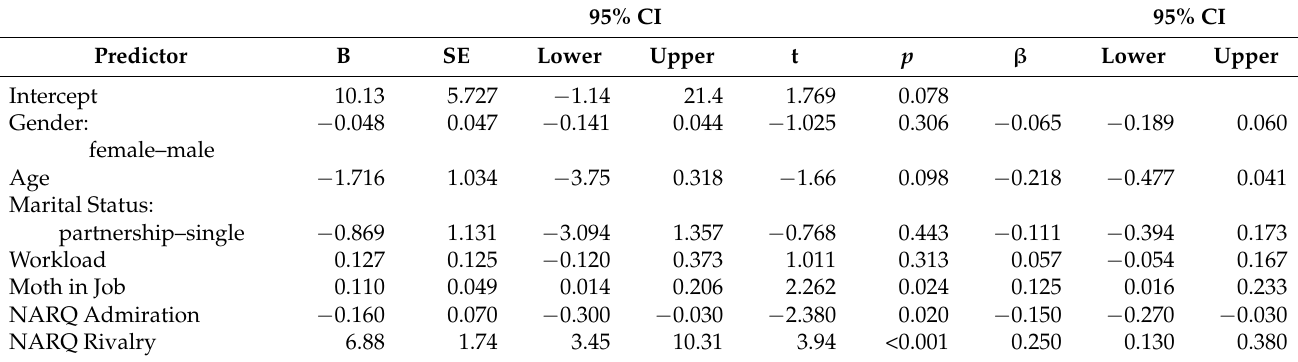
Table 11. Linear Regression Analysis for Depersonalisation.